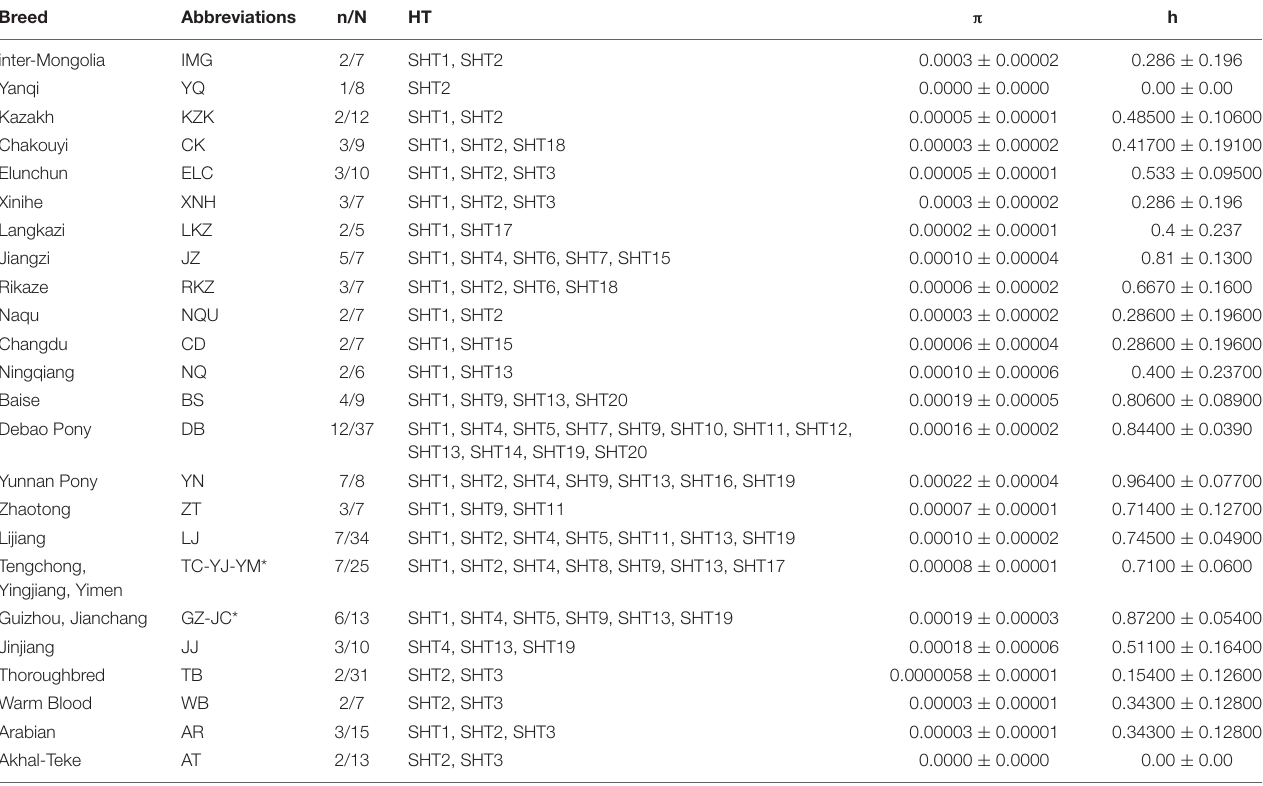
TABLE 1 | ECAY genetic diversity of Chinese indigenous horse populations.